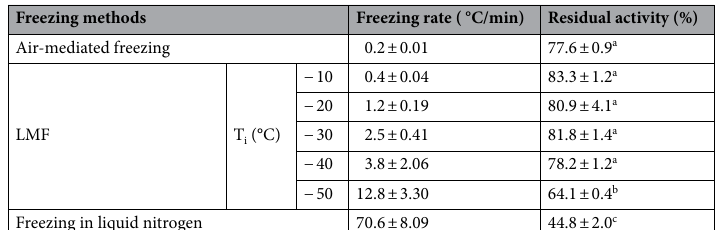
Table 1. Residual activities of l-lactate dehydrogenase according to freezing rate. LMF liquid-mediated freezing, T i initial temperature of isopropyl alcohol. a–c Different superscript letters denote significant differences between treatments ( p < 0.05). The means were compared using ANOVA and ranked using Duncan’s multiple range test.